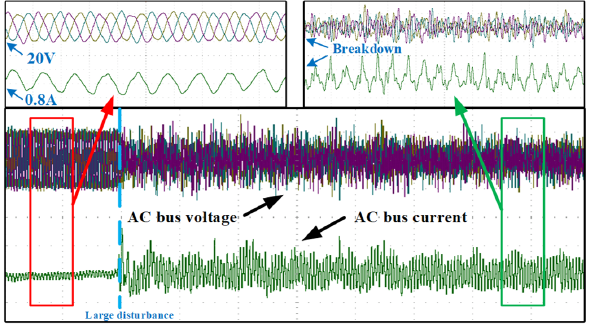
Figure 23. The curves of AC bus voltages and currents in the charging state (Group D).